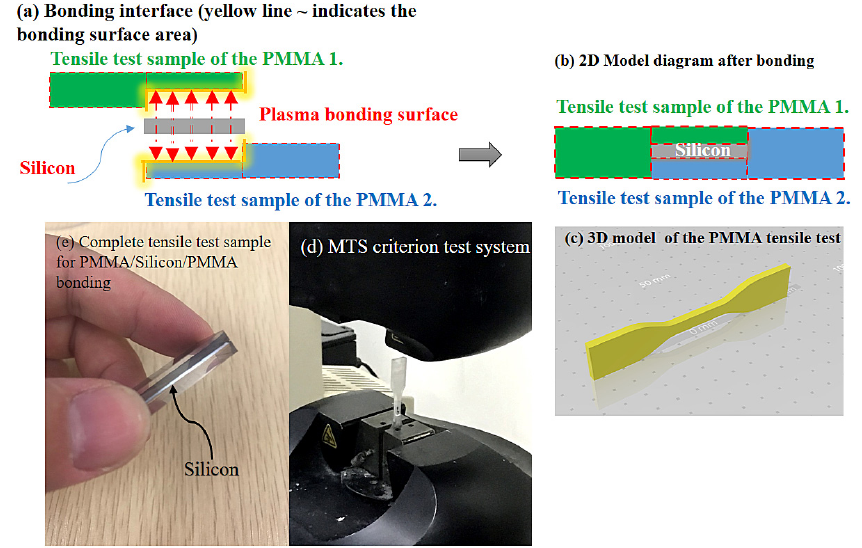
Figure 2. ( a , b ) Schematic illustration of the bonded sample for tensile testing. ( c ) 3D model of the tensile test (ASTM D638, type V); dimensions of the tensile test sample: width (9.53 mm) and length (63.5 mm). ( d ) MTS criterion test system. ( e ) Complete tensile test sample for microfluidic device H 2 O plasma bonding.